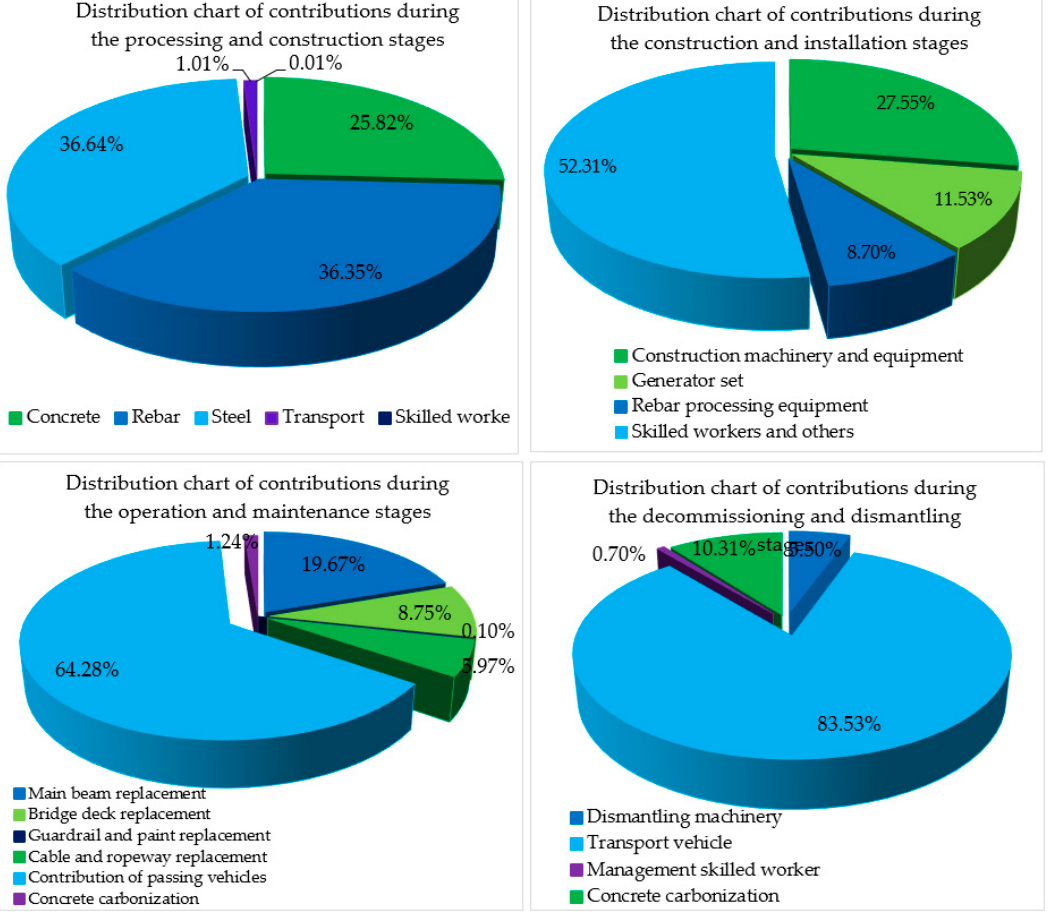
Figure 7. Schematic diagram of the environmental impact contribution of each stage of the cable- Figure 7. stayed bridge.